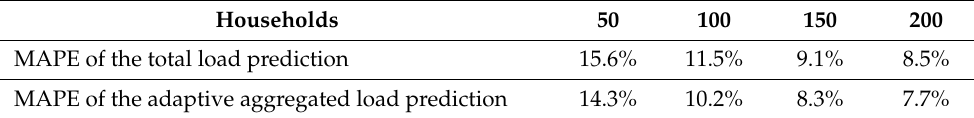
Table 6. MAPE of the short-term load forecasting results for different total numbers of households. Households MAPE of the total load prediction MAPE of the adaptive aggregated load